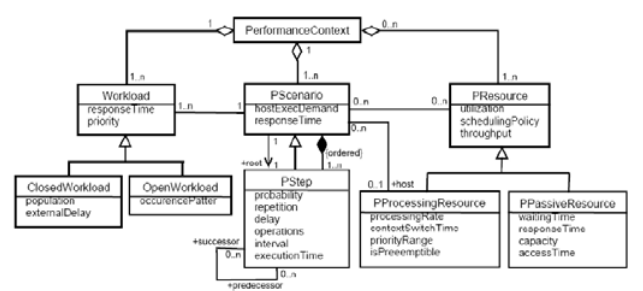
Fig. 2. The general model of efficiency (Group,